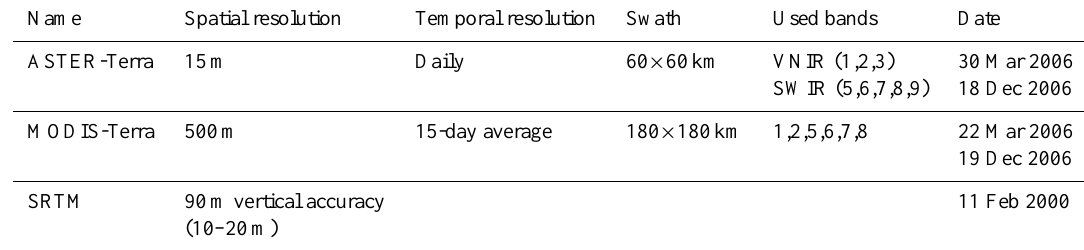
Table 1. Description of the